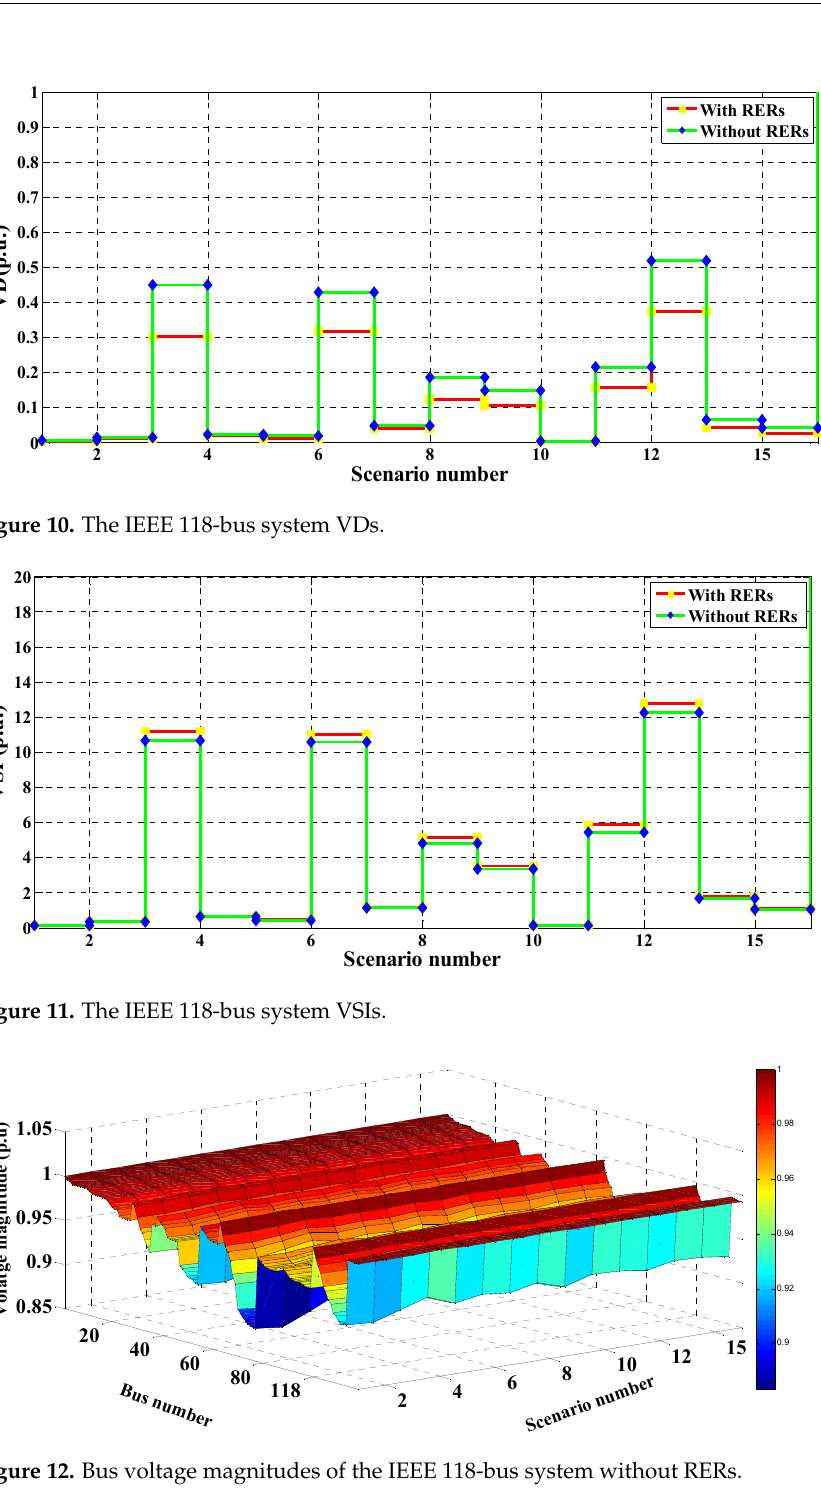
Figure 12. Bus voltage magnitudes of the IEEE 118-bus system without RERs.